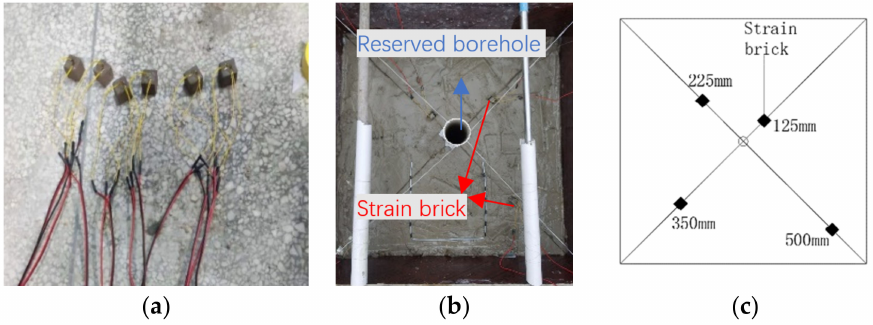
Figure 3. Strain test:( a ) Strain brick, ( b ) Burial process, ( c ) Diagram of strain brick arrangement.